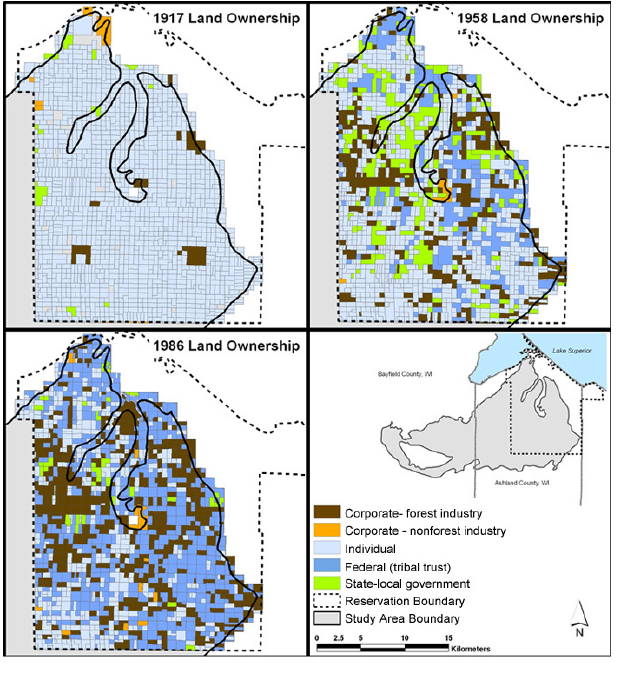
Fig. 6. Land ownership composition of the Bad River Indian Reservation, Wisconsin, at three times: 1917, 1958, 1986.